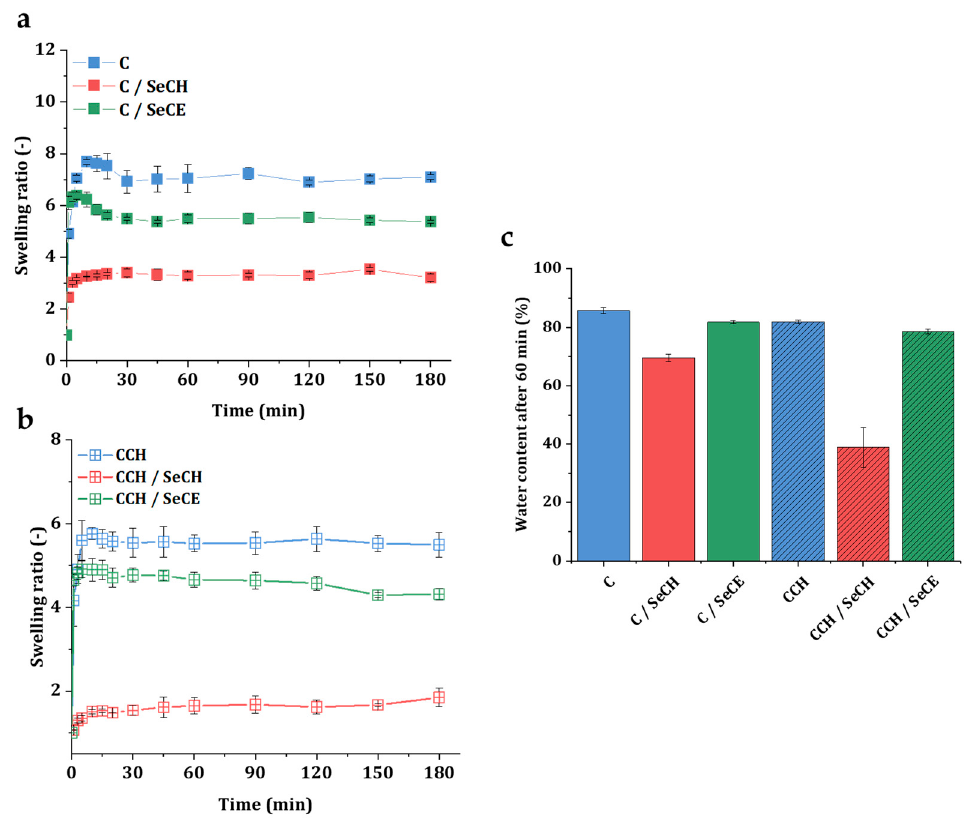
Figure 6. The swelling ratio of the C–SeNPs scaffolds ( a ), CCH–SeNPs ( b ), and water content in the point of equilibrium at 60 min ( c ).